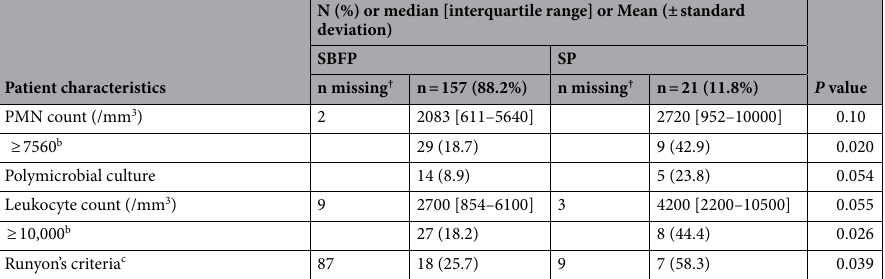
Table 1. Main characteristics of 178 patients with cirrhosis and spontaneous bacterial/fungal peritonitis (SBFP) or secondary peritonitis (SP). SBFP spontaneous bacterial/fungal peritonitis, SP secondary peritonitis, SAPSII Simplified Acute Physiology Score version II, LDH lactate deshydrogenase, PMN polymorphonuclear leukocytes. † Number of missing observations. If ≥ 1. *Some patients had more than one cause of cirrhosis. a Defined as platelet count < 150 G/L and/or bilirubin > 50 µmol/L and/or prothrombin time < 40%. b Dichotomization by maximizing the Youden index of the ROC curve. c At least 2 ascitic fluid criteria among